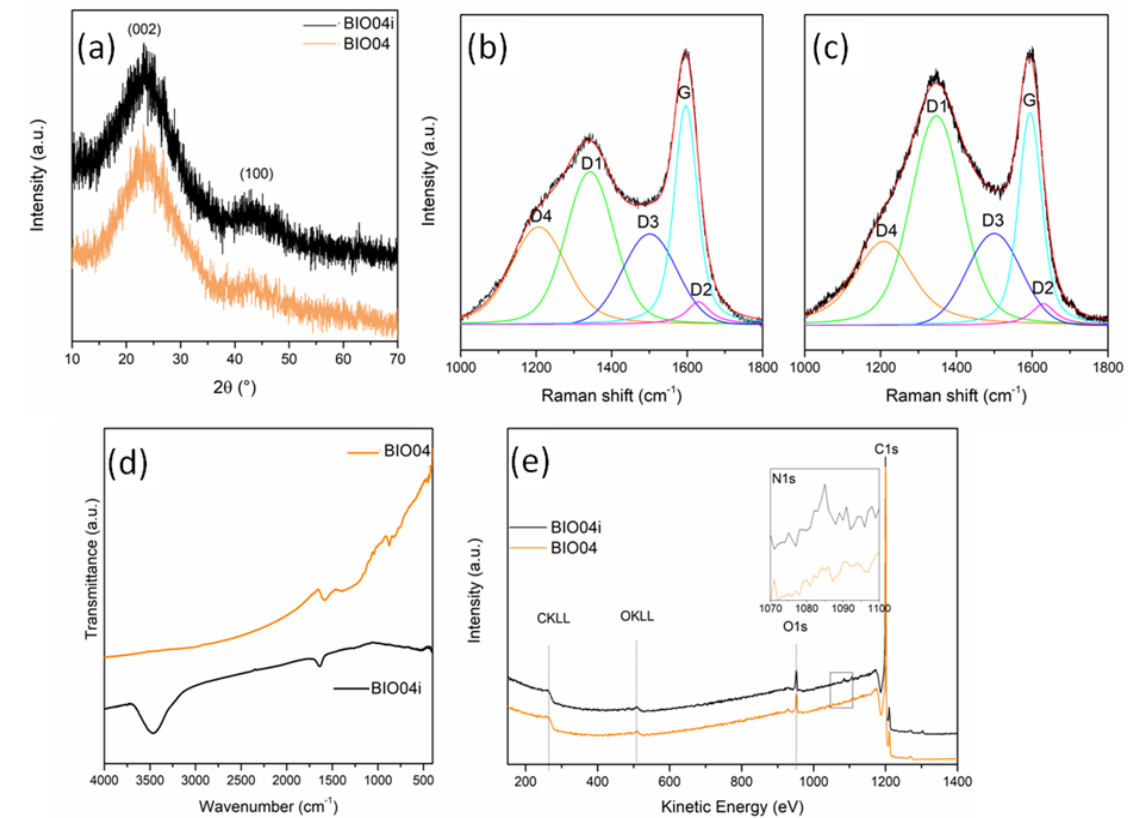
Figure 6. ( a ) XRD patterns of BIO04 and BIO04i; curve-fitted Raman spectra of ( b ) BIO04 and ( c ) BIO04i; ( d ) FT-IR spectra of BIO04 and BIO04i; and ( e ) XPS wide spectra of BIO04 and BIO04i.